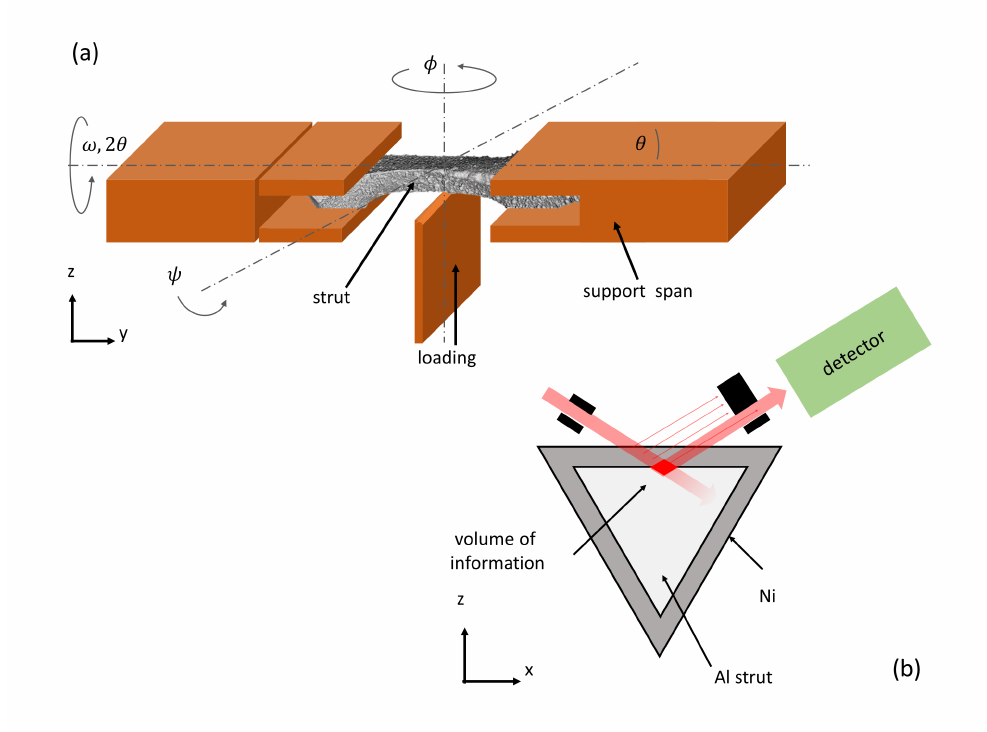
Figure 3. Schematic representation of the experimental setup. ( a ) The strut is fixed by the support span. The loading direction is positive vertical and the analysis is performed below the upper surface the interface using an immersed beam and narrow slits. ( b ) Schematic cross section through the middle of the strut. The slit and detector setup and the beam at fully immersed position is shown.